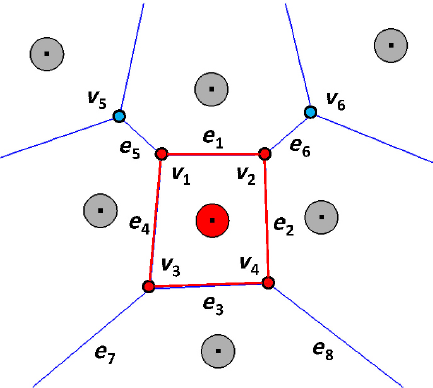
Fig. 9 An expanding Voronoi cell (red) with: cell vertices v 1 – v 4 , cell edges e 1 – e 4 , radiating edges e 5 – e 8 , and neighboring vertices v 5 , v 6 .